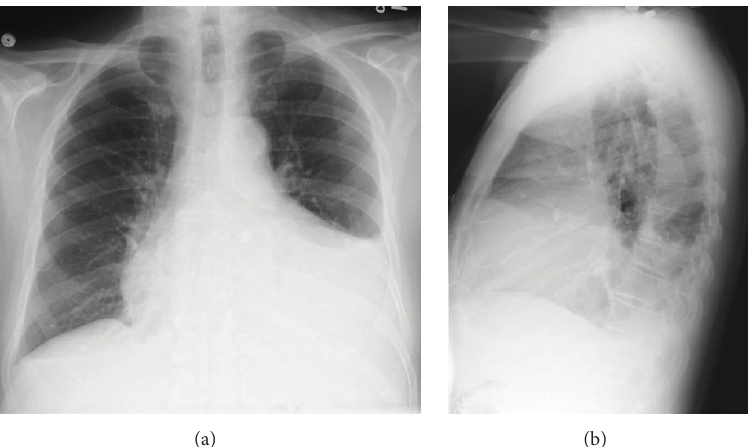
Figure 2: Conventional chest radiograph on the day of admission. The images show an enlarged cardiac silhouette, bibasilar opacities, and left-sided pleural effusion.